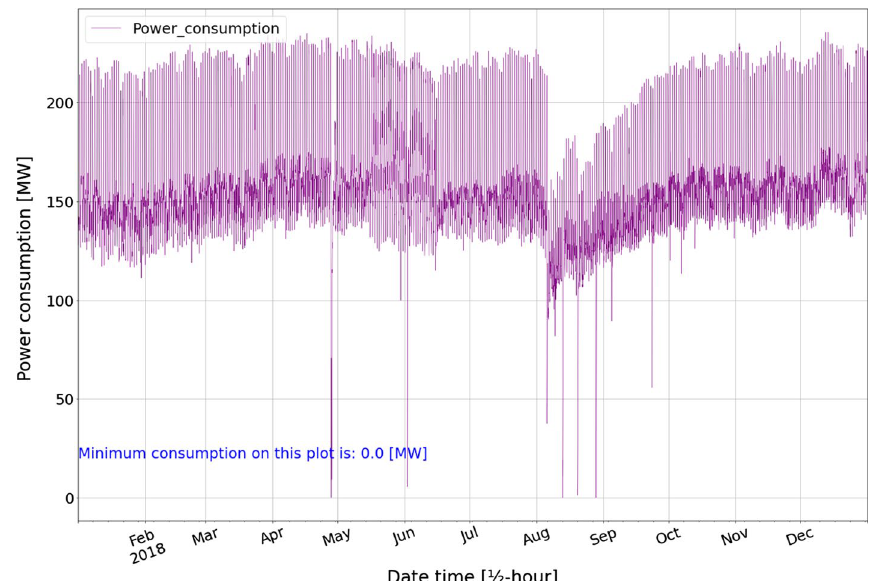
Fig. 22 The ½-hourly load profile of Lombok in 2018